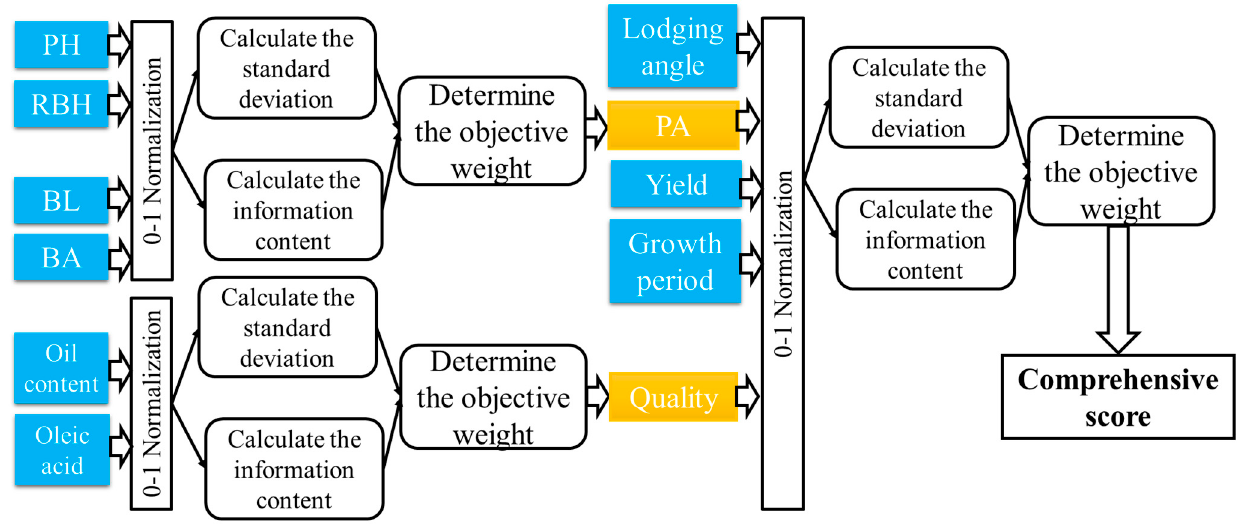
Figure 1. Diagram process for calculating the comprehensive score. BA, branch angle; BL, branch length; PA, plant architecture; PH, plant height; RBH, relative branch height. The rectangles with blue color indicate the raw data, and the rectangles with yellow color indicate the comprehensive traits calculated from the raw data.